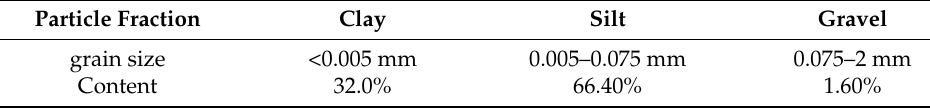
Figure 2. Preparation of soil samples ( a ) raw materials; ( b ) sample profiles. Table 3. The Granulometric Composition of Red Clay.